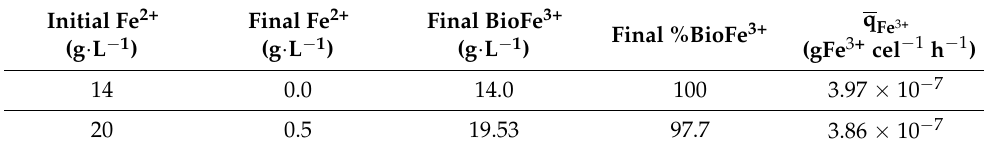
Table 3. Concentration of Fe 2+ oxidized and BioFe 3+ generated, percentage of BioFe 3+ generated, and specific productivity of Fe 3+ ions (q ) after 56 h, assayed in two initial Fe 2+ Fe 3 +